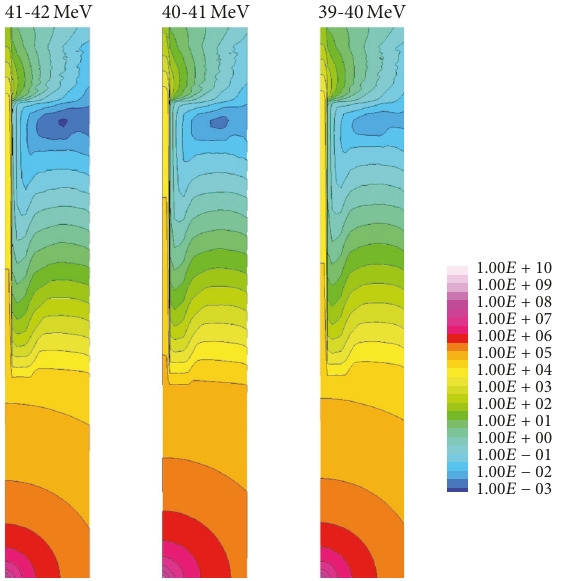
Figure 5: Neutron flux distribution of 50 cm thick concrete shield- ing